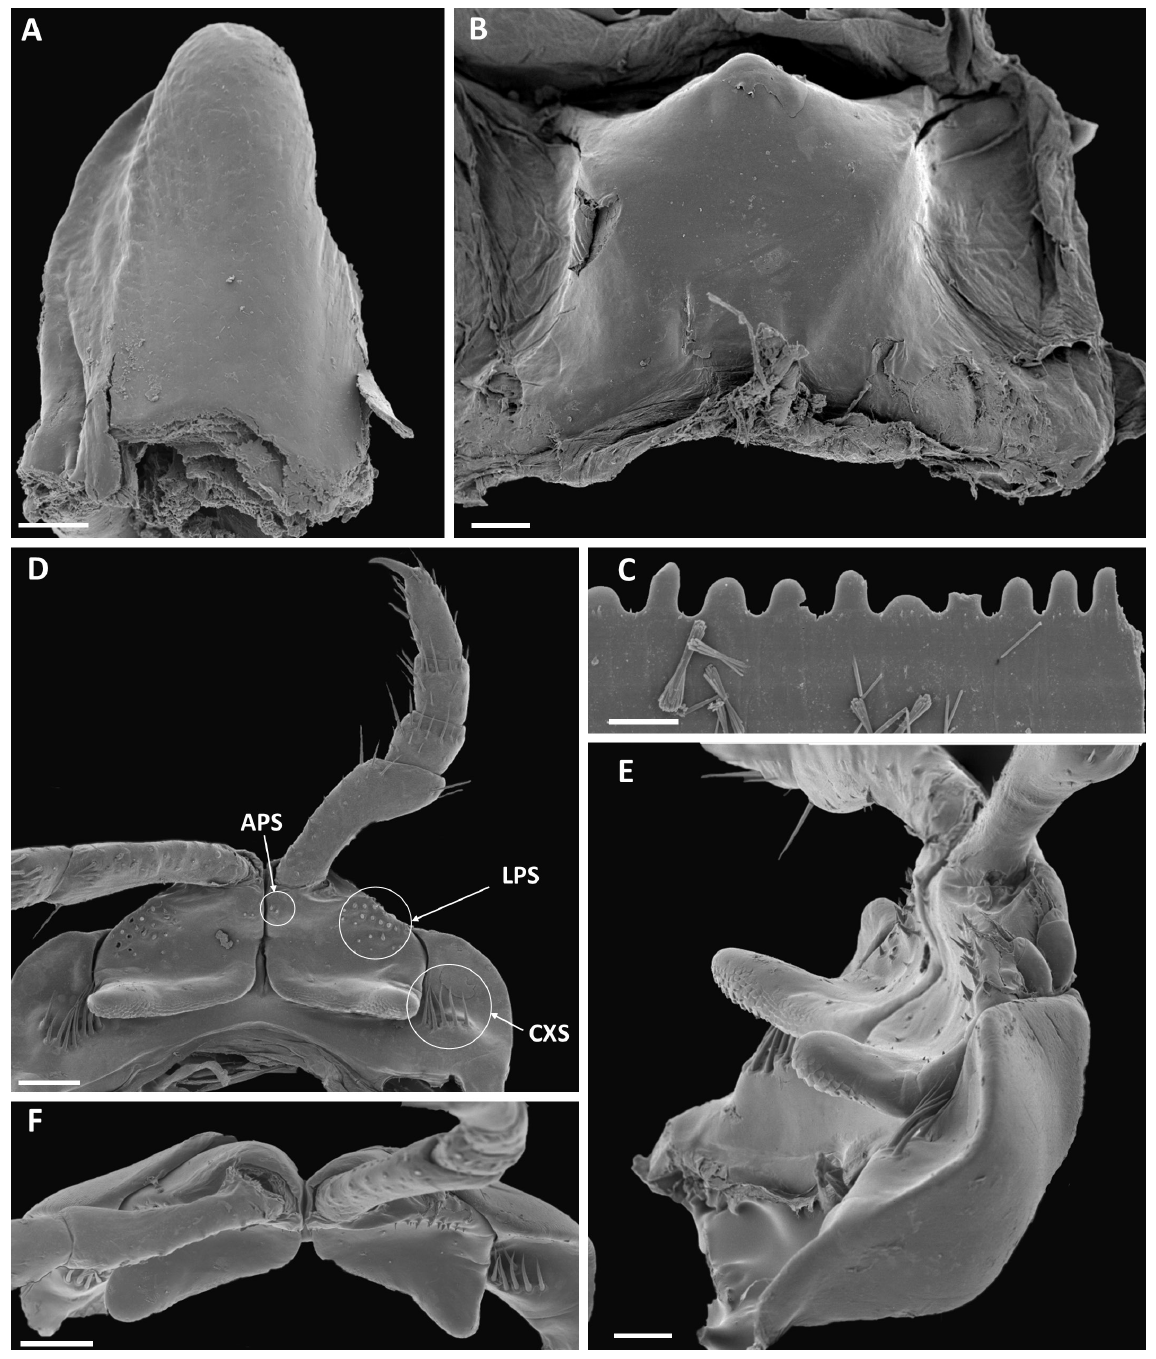
Fig. 62. Xystopyge bentemarieae sp. nov., holotype, ♂ (NHMD 621766). A . Gonopod sternum (sternum 8). B . Sternum 9. C . Midbody dorsal limbus. D–F . First pair of legs. D. Anterior view. E. Lateral view. F. Ventral view. Abbreviations: APS = mesapical prefemoral sensilla; CXS = coxosternal setae; LPS = lateral prefemoral sensilla. Scale bars: A = 0.05 mm; B, E = 0.1 mm; C = 0.01 mm; D, F = 0.2